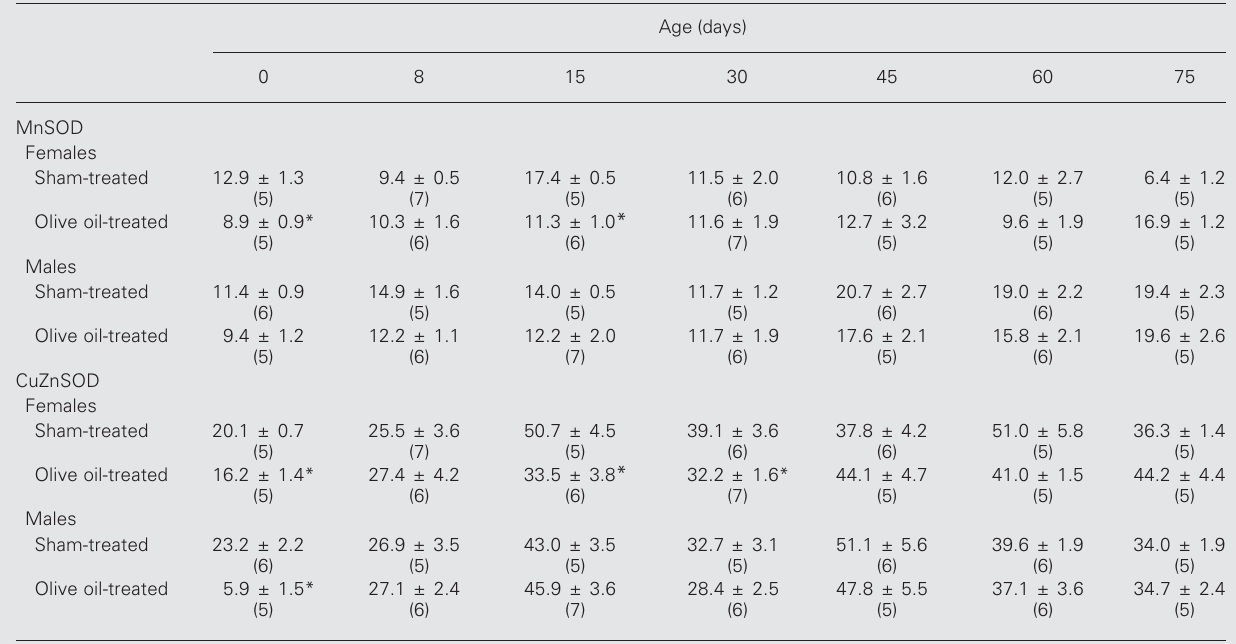
Data are reported as means ± SEM U/mg protein, for the number of rats given in parentheses. *P<0.05 compared to sham-treated animals of the same age ( t